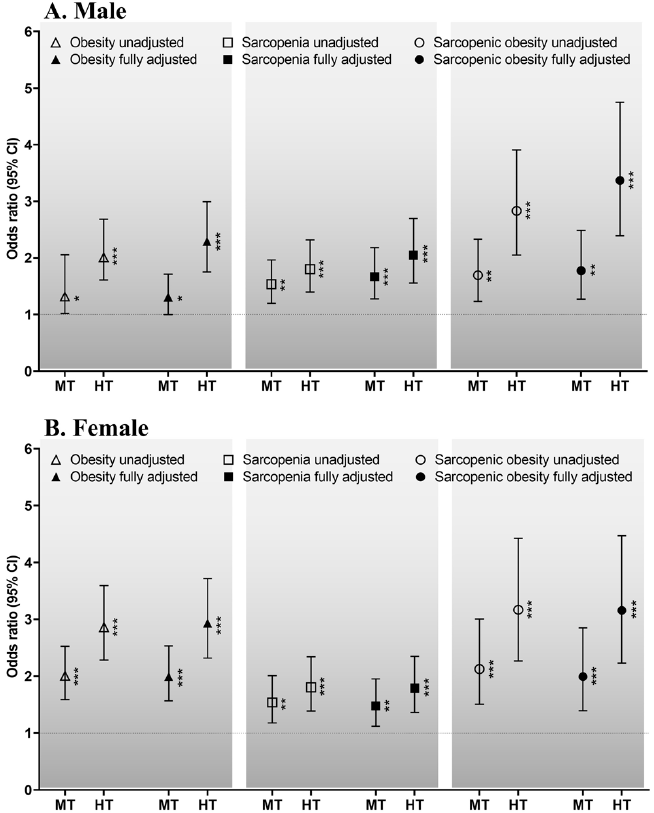
Figure 2. Sex-specific ORs for the relationship of the TyG index with obesity, sarcopenia, and sarcopenic obesity for males ( A ) and females ( B ). Dotted line: reference; solid line: 95% confidence interval (CI); white or black triangles, rectangles, and circles: ORs. * p < 0.05, ** p < 0.01, *** p < 0.001 for the ORs for obesity, sarcopenia and sarcopenic obesity, compared with the lowest tertile. The potential confounders: age, educational level, household income, medication, smoking, alcohol consumption, moderate-to-vigorous physical activity, nutrition, and medical history. Abbrevia-